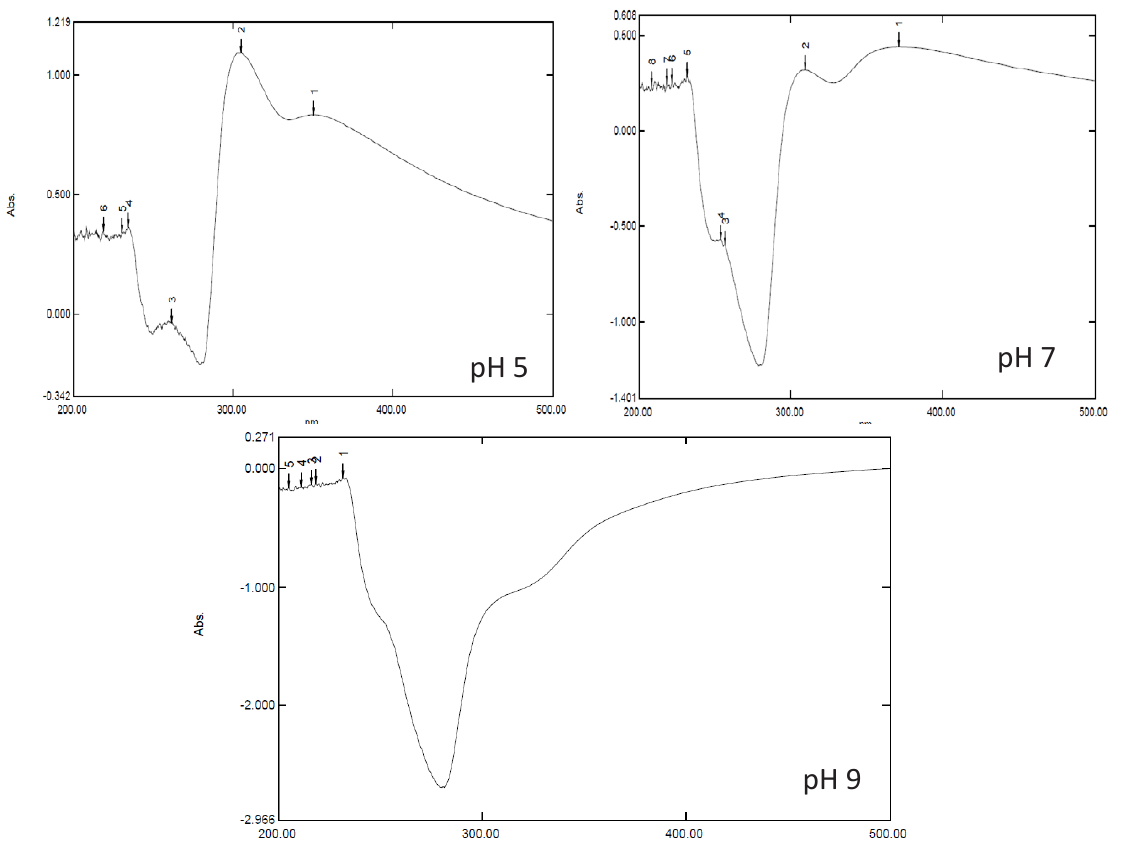
Fig. 5. UV-vis spectrum of silver nanoparticle produced by Escherichia coli at pH 5, 7 and 9